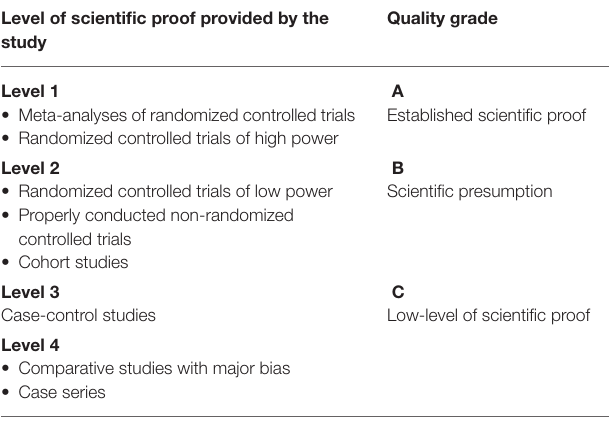
TABLE 1 | Level of scientific evidence and gradation of